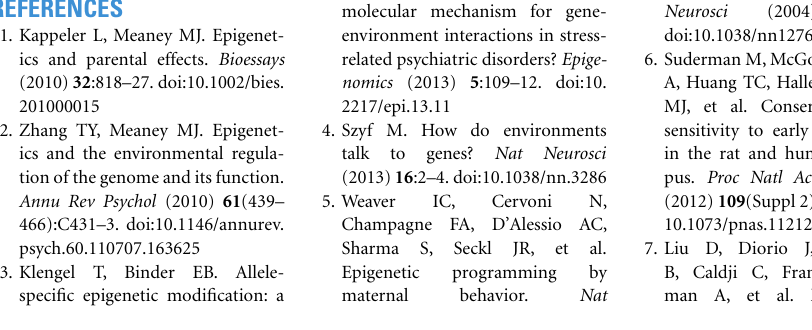
FIGURE 9 | Mechanistic model of the relationships/interactions between GR and FKBP5 methylation in PTSD . Early life experience may impact both GR and FKBP5 gene methylation potentially in interaction with genotype. GR responsiveness is increased in PTSD, likely resulting from reduced GR methylation, with consequent increased GR expression, ultimately resulting in lowered cortisol levels. Low cortisol levels would serve to decrease FKBP5 gene expression through an intracellular loop mediated by GREs in the FKBP5 gene. Later life experience ± therapy, can also impact methylation of both genes, but most likely in distinct manners. A glucocorticoid-induced demethylation of FKBP5 will allow the